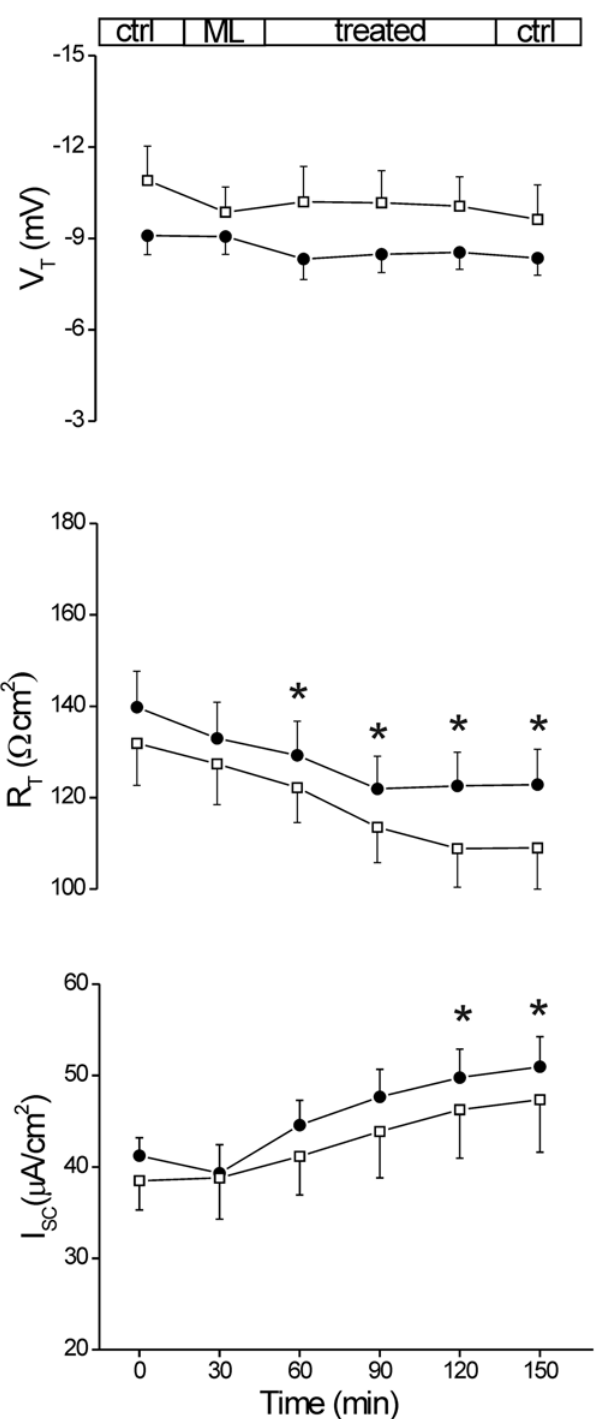
Figure 3. Effect of mucosal exposure to VCC. Human sigmoid colon specimens mounted in Ussing chamber were sequentially monitored for transepithelial potential difference (V T , mV) and tissue resistance (R T , V cm 2 ) changes under open-circuit condition, and for short circuit current (I SC , m A/cm 2 ) with voltage clamped to zero. Electrical parameters were measured in the basal state (Ctrl) and during incubation (Treated) with VCC 1 nM (filled circles: n=10; m=7) or 0.5 nM (empty squares: n=5; m=2). All tissues were treated with mucolytic solution (ML) containing papain (5 U/100 ml) plus L-cysteine (5 mM) prior exposure to VCC. Each data point represents the average 6 S.E.M. of measurements in n specimen from m